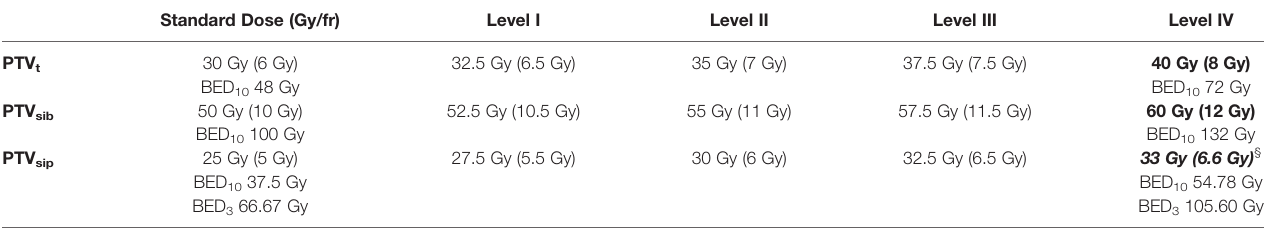
TABLE 1 | SBRT standard dose and levels of SBRT dose escalation proposal*. Standard Dose